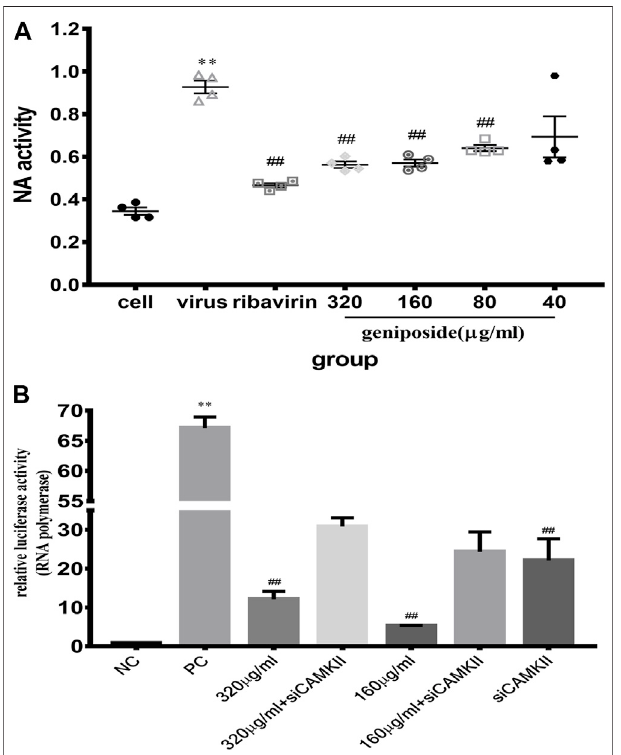
FIGURE 4 | (A) Effect of geniposide on neuraminidase activity levels in MDCK cells infected with IAV. Values are expressed as the mean ± SEM ( n (cid:1) 4), ** p < 0.01 compared to the normal control group, and ## p < 0.01 comparedtotheviruscontrolgroup. (B) RelativeluciferaseactivityofIAV polymerase in HEK-293T cells. Relative luciferase activity was detected using a dual-luciferase reporter assay system. Values are expressed as the mean ± SEM ( n (cid:1) 4), ** p < 0.01 compared to the negative control group (NC), and ## p < 0.01 compared to the positive control group (PC).